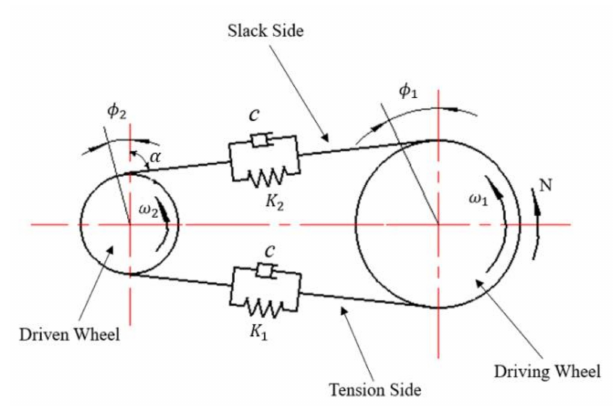
Figure 3. Chain drive transverse vibration model schematic and